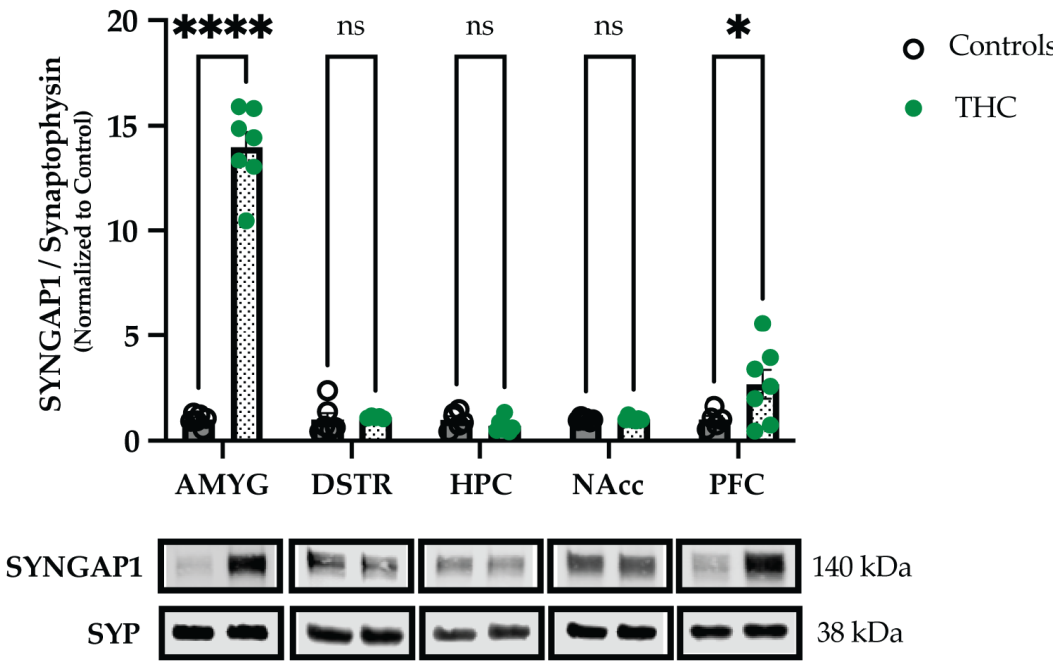
Figure 4. Exposure to THC in adolescence affects levels of SYNGAP1 in the amygdala and PFC . Male rats were exposed to Δ 9 -tetrahydrocannabinol (THC) or vehicle (i.e., controls) in mid-adoles- cence/puberty (PND 42-52) and synaptosomal fractions were extracted from five different brain re- gions in late adolescence (PND 64) on drug abstinence day 12. Western blotting analyses showed significant upregulation in synaptic levels of SYNGAP1 in the amygdala and prefrontal cortex of THC-treated animals (N = 6 – 7 animals per group; N = 1 outlier in DSTR and N = 1 outlier in PFC). Graph data are presented as mean ± SEM. Representative Western blots are shown below the graphs, with the approximate molecular weights of observed band sizes indicated to the right.